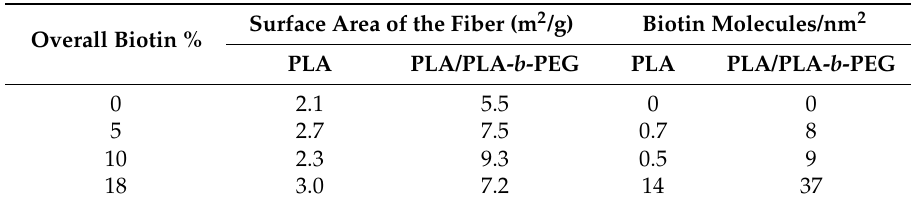
Table 1. Fibers surface area values and amount of biotin molecules per square nanometer at the fibers surface. Surface Area of the Fiber (m 2 /g) Biotin Molecules/nm 2 Overall Biotin % PLA PLA/PLA- b -PEG PLA PLA/PLA- b